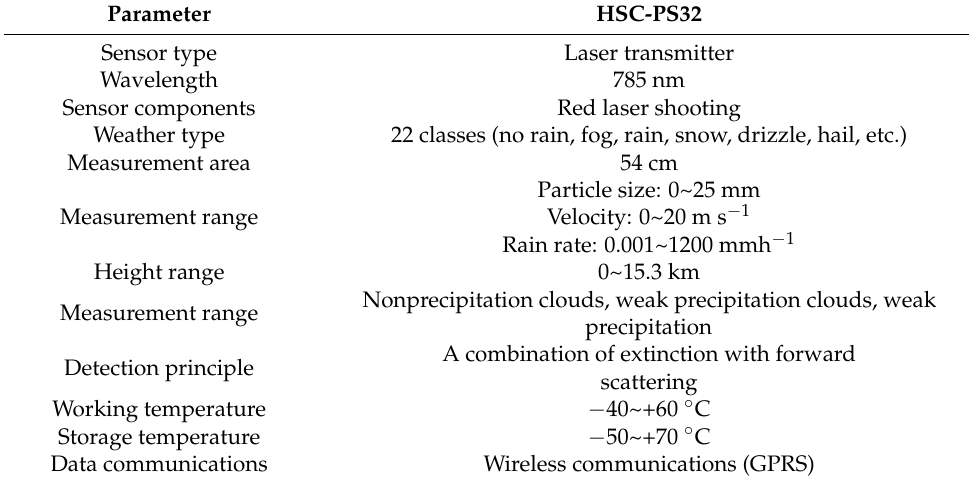
Table 3. Main specifications of